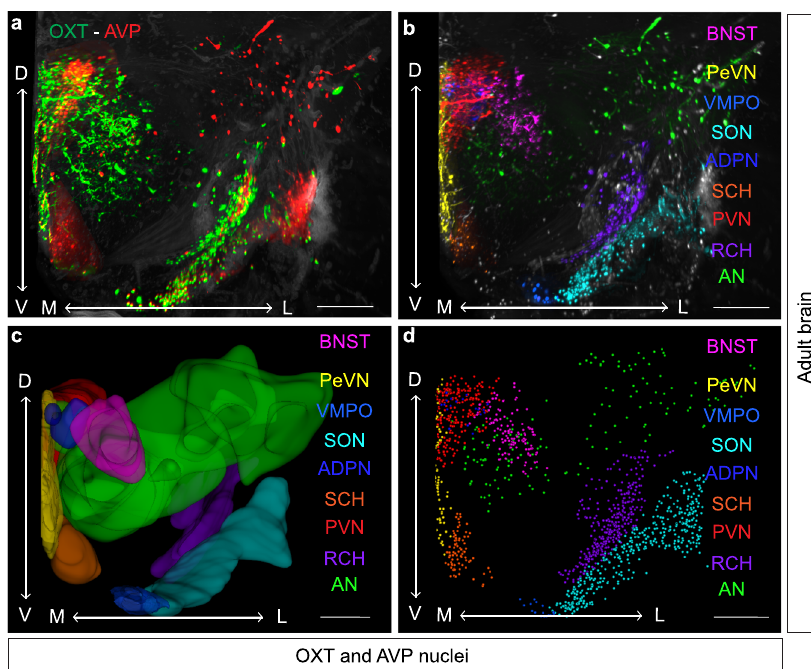
Fig. 1 iDISCO + , a useful tool for distinguishing between nuclei. Representative image of the hypothalamus of one hemisphere of an adult mouse brain processed with the iDISCO + protocol and stained for OXT (green) and AVP (red) ( a ) in which distinct neuronal populations can be easily resolved. The image shows the hypothalamic area displaying oxytocinergic and vasopressinergic neurons pseudocolored in each hypothalamic nucleus and surrounding areas such as the BNST ( b ). OXT and AVP expression in each nucleus are represented using the Imaris surface tool ( c ). OXT and AVP neurons in each nucleus are identi fi ed and outlined for performing quantitative analysis ( d ). Arrows: D dorsal; V ventral; M medial; L lateral. PeVN periventricular nucleus, ADPN anterodorsal preoptic nucleus, BNST bed nucleus of stria terminalis, VMPO ventromedial preoptic nucleus, SON supraoptic nucleus, PVN paraventricular nucleus, RCH retrochiasmatic area, AN accessory nucleus, SCH suprachiasmatic nucleus. Scale bar: 300 µ